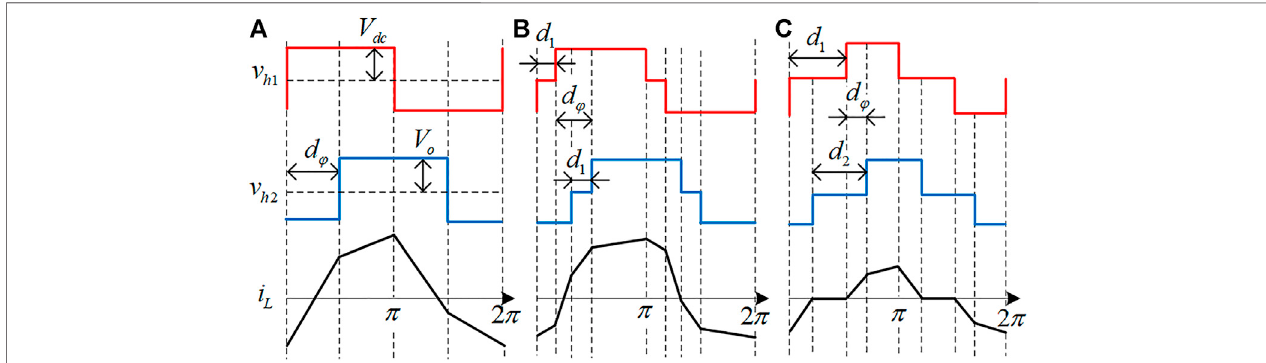
FIGURE 3 | Operation principles of DAB converters with (A) SPS; (B) DPS; (C) CTPS.